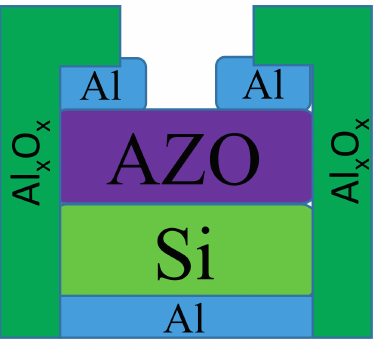
Figure 9. The structure of the AZO/Si SBD with Al x O x guard